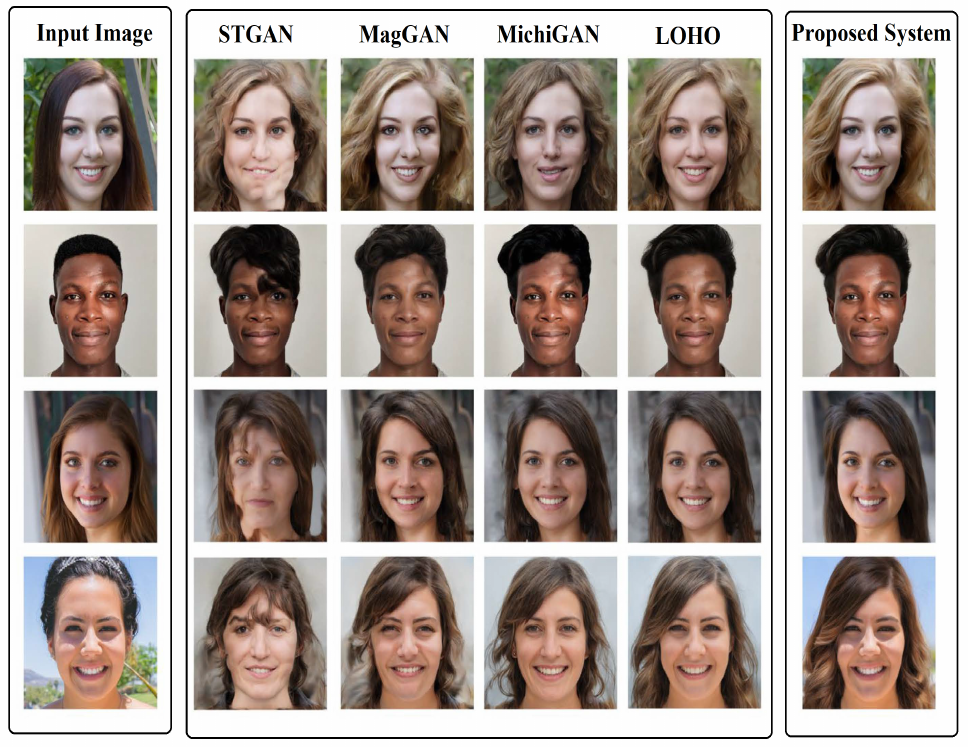
Figure 6. A comparison of the outcomes produced by our approach and other generative